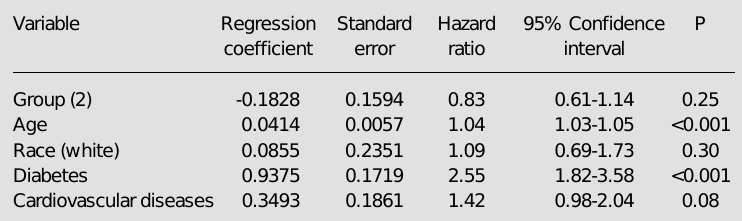
Table 5 - Multivariate proportional hazard analysis of variables associated with mortality in dialysis patients. Cox proportinal regression